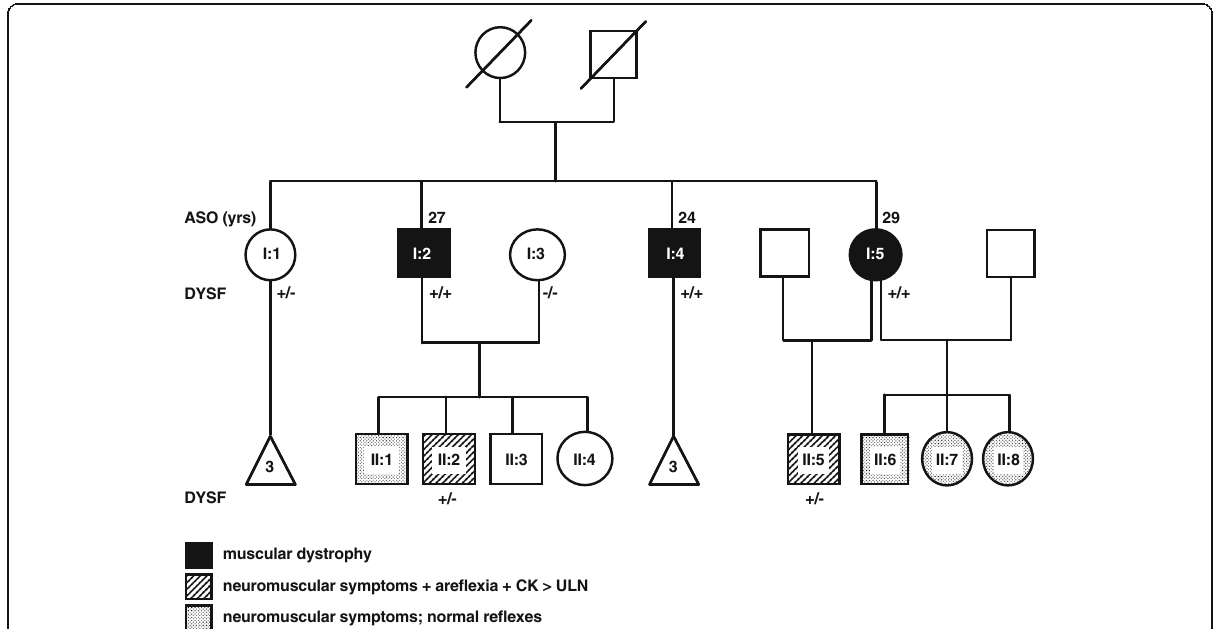
Fig. 1 Family pedigree and validated genotypes for the novel DYSF stop gain variants. Circles represent females and squares represent males. White figures (excluding triangles) symbolize unaffected members; solid symbolize disease cases, striped represent cases with neuromuscular symptoms, areflexia and elevated creatine kinase (CK) levels above the upper limit of normal (ULN); and speckled symbolize cases with neuromuscular symptoms but normal deep tendon reflexes. Individuals denoted by triangles were of uncertain clinical status and “ / ” indicate deceased individuals. ASO refers to age at symptom onset in years (yrs). Generation 1 (G1) refers to I:1 to I:5 and G2 refers to II:1 to II:8. DYSF refers to the dysferlin gene. ‘ + ’ refers to the presence of the DYSF mutation, ‘ - ‘ to wild-type DYSF, +/ − refers to heterozygous individuals and +/+ to homozygous